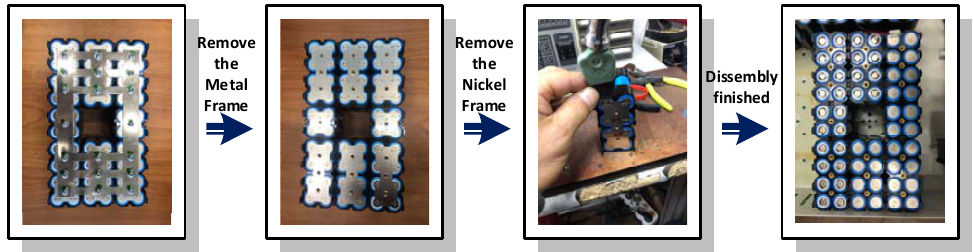
pack. battery pack. pack.